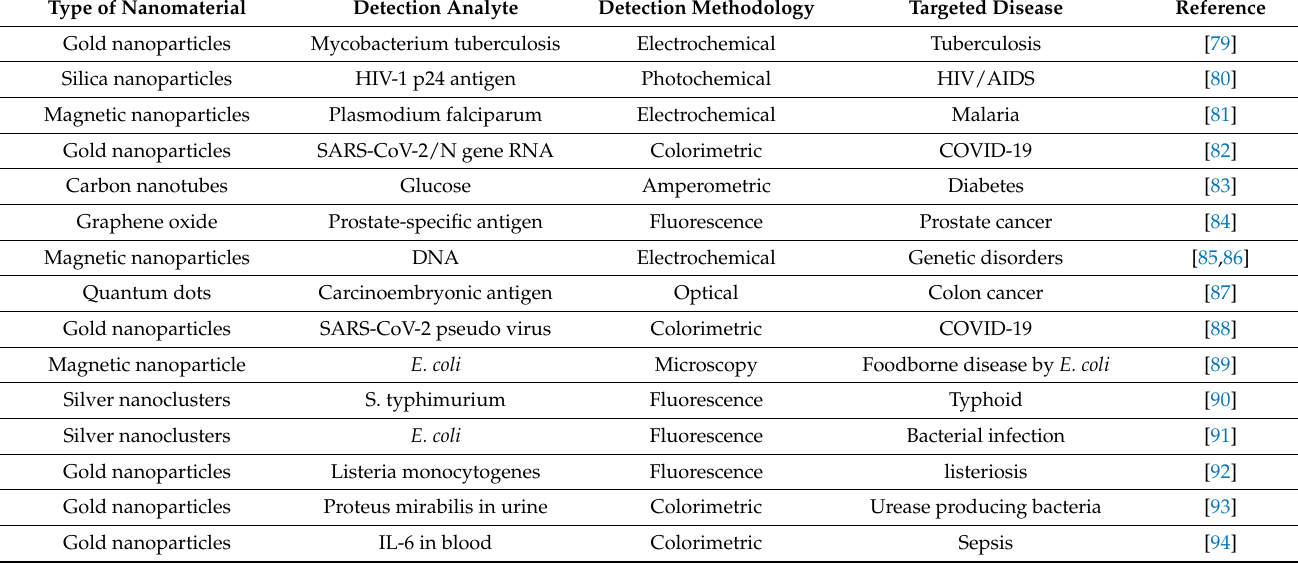
Table 2. A summary of selected nanomaterial-based detection methods for diseases prevalent in developing